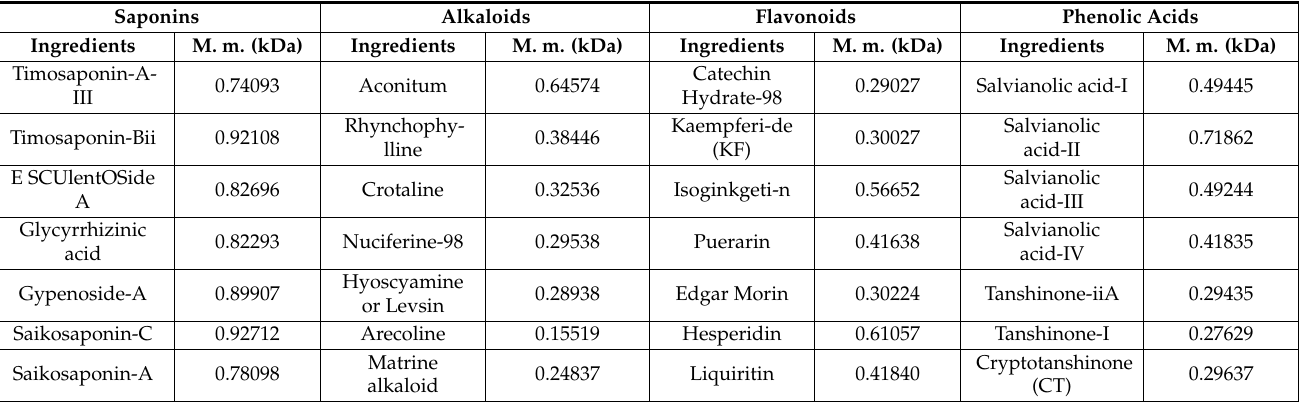
Table 1. Some TCM relative molecular masses (M.m.)